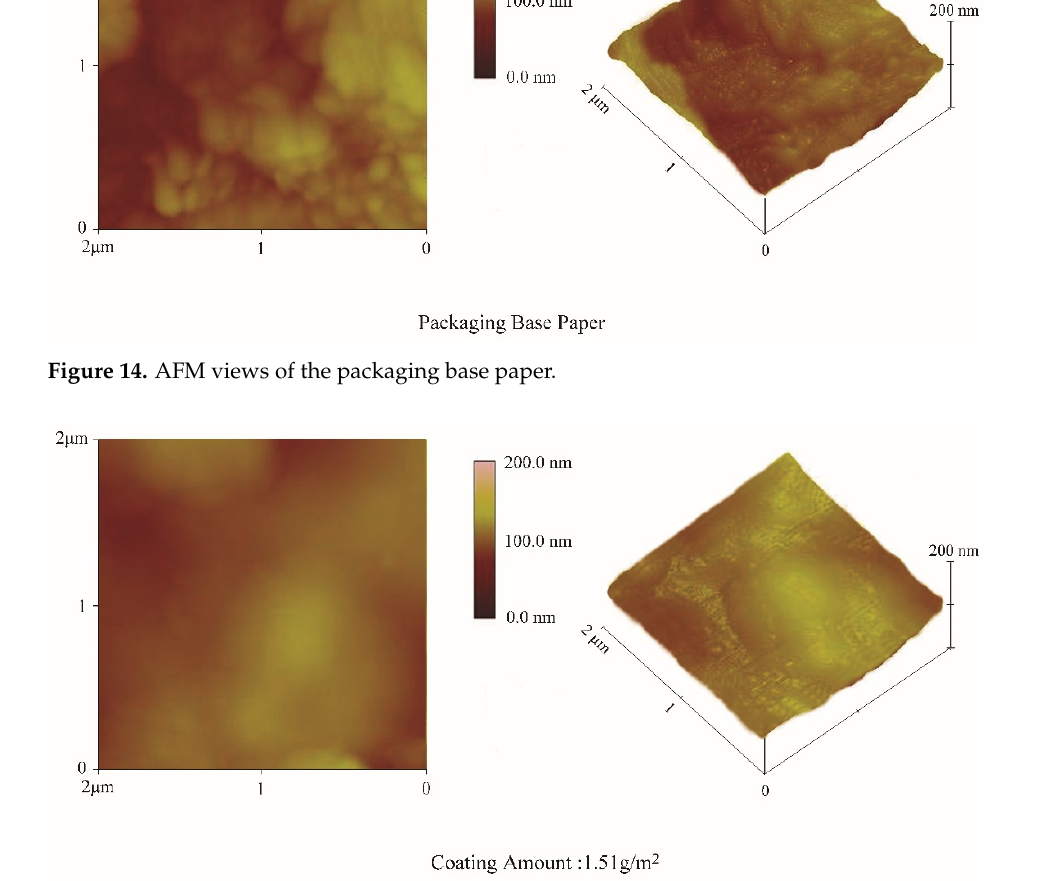
Figure 16. AFM views of the coated packaging paper (coating amount: 2.55 g/m 2 ).